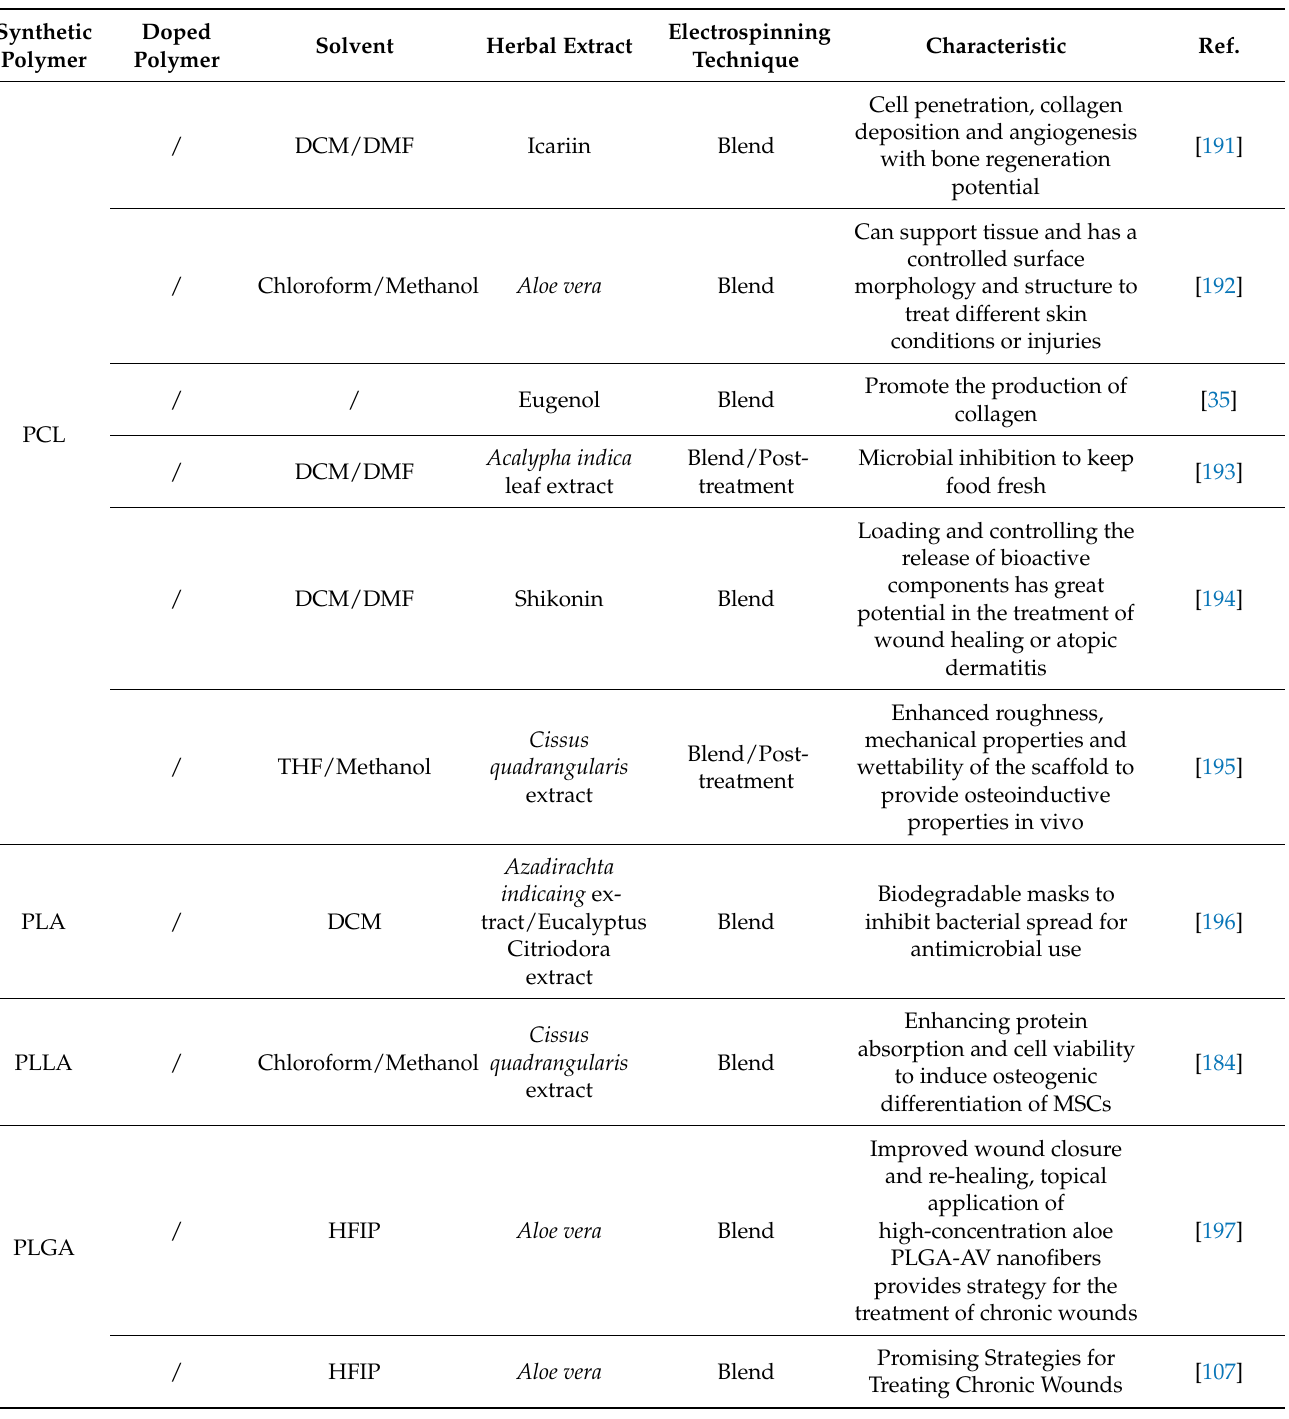
Table 3. Characteristics of polymer nanofibers synthesized by electrospinning herbal